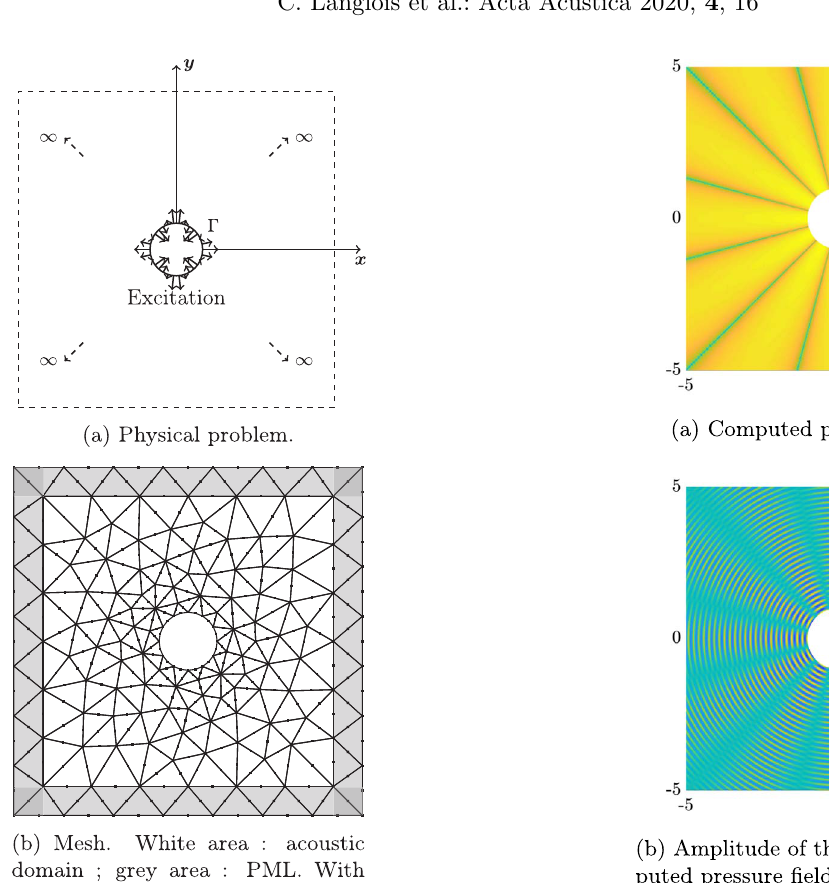
Figure 9. 2D encompassed problem. (a) Physical problem. (b) Mesh. White area: acoustic domain; grey area: PML. With l x = l y = 5 m and L x = L y = 6 m.